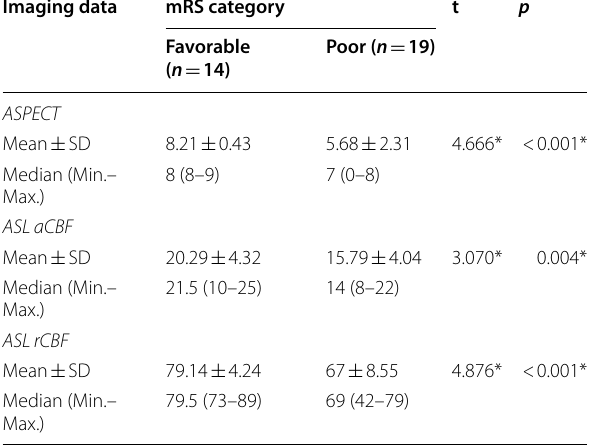
Table 3 Correlation between imaging data (ASPECTS and ASL) and clinical outcome (modified Rankin score) in acute stroke patients